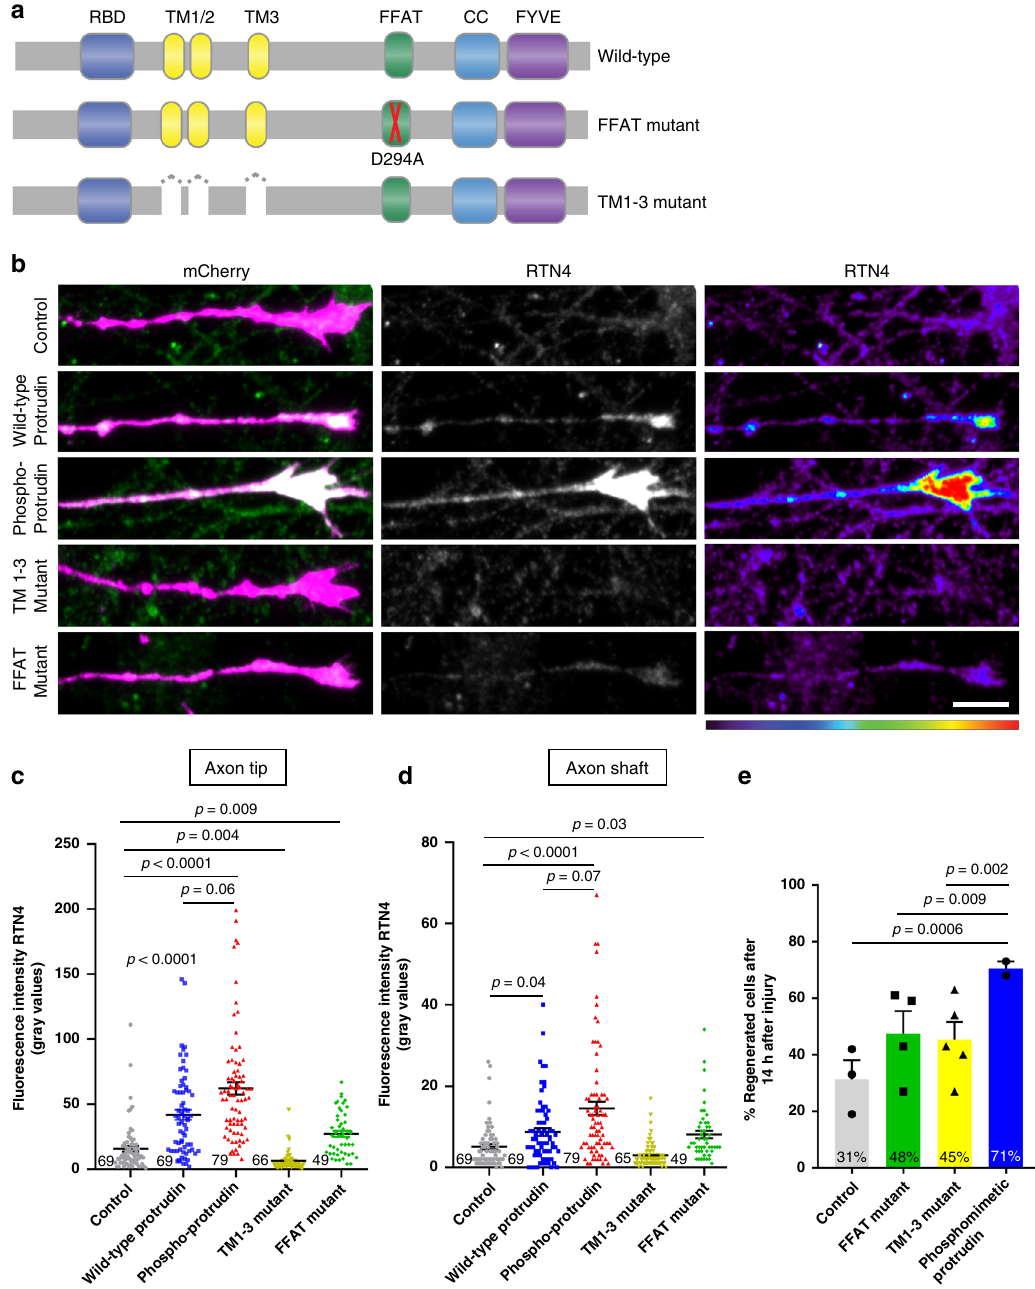
Fig. 4 Protrudin overexpression enhances ER presence at growth cones and this interaction is required for successful axon regeneration. a Schematic representation of Protrudin endoplasmic reticulum domain mutants. b Representative images of RTN4 immuno fl uorescence (green) in the distal axon of neurons expressing the indicated m-Cherry Protrudin constructs (magenta). Scale bar is 10 μ m. c , d Quanti fi cation of RTN4 fl uorescence intensity at the axon tip and shaft ( p < 0.0001, Kruskal – Wallis with Dunn ’ s multiple comparisons test). Error bars represent mean ± SEM. e Percentage of regenerating axons in neurons expressing mCherry-Protrudin domain mutants — FFAT ( n = 4 independent experiments, 60 neurons) and TM1-3 ( n = 5 independent experiments, 45 neurons) compared to phosphomimetic Protrudin as a positive control ( n = 2 indepe n dent experiments, 21 neurons), and mCherry as a negative control ( n = 3 independent experiments, 41 neurons). Error bars represent mean ±